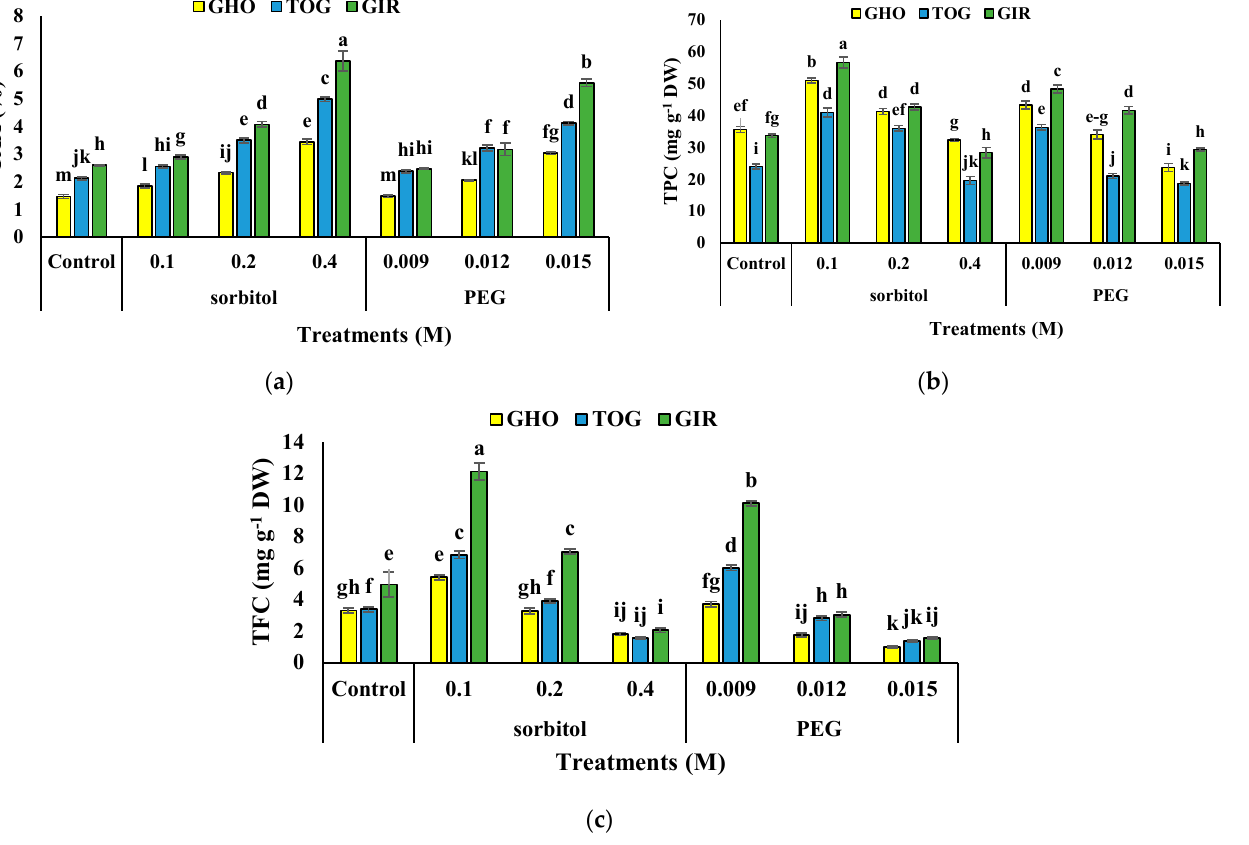
Figure 2. Effects of PEG and sorbitol on TAA ( a ), TPC ( b ), and TFC ( c ) of 3 melon genotypes. Different letters are significantly different based on Duncan’s multiple range test ( p ≤ 0.05). GHO, TOG, and GIR are the Ghobadloo, Girke, and Toghermezi genotypes, respectively. Table 3. The ANOVA for the effects of PEG and sorbitol on the biochemical traits of three melon geno- types under in vitro conditions.